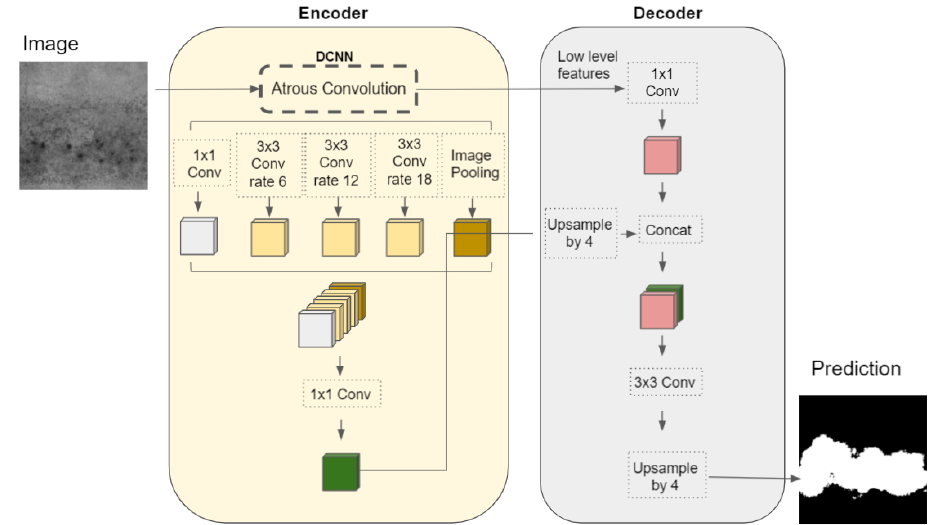
Figure 5. Architecture diagram of the DeepLabV3+ network